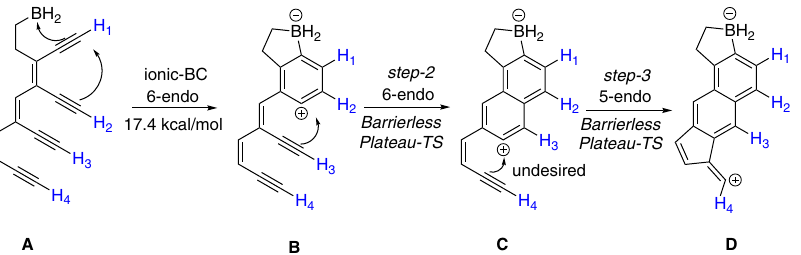
Fig. 14 Boryl group-triggered Bergman cascade resulting into the terminal fi ve-membered fulvene-type cation. Structures A , B , C , and D correspond to the polyenyne substrate, phenyl cation, naphthyl cation, and the fi nal product of cascade cyclization respectively. Calculations were performed using the